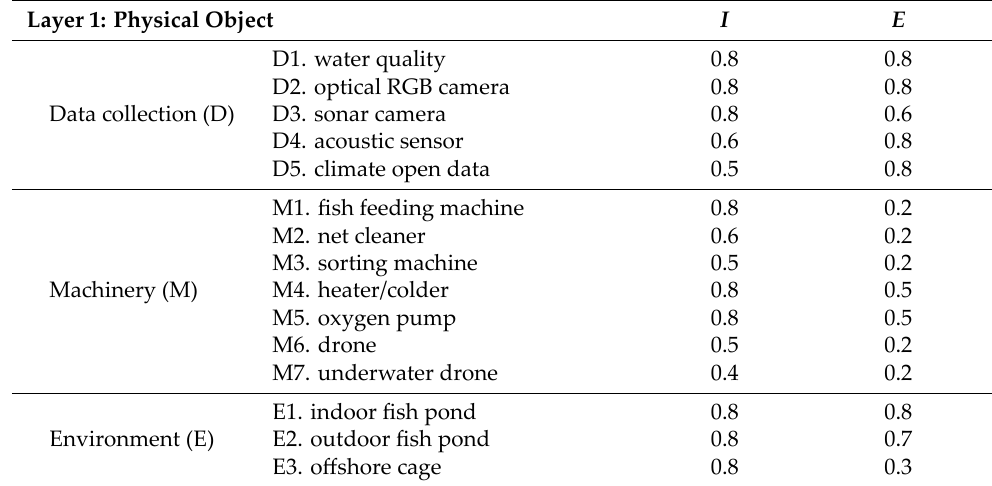
Table 1. Layer 1 physical objects used in fish farm management and their feasibility evaluation in terms of indexes I and E .